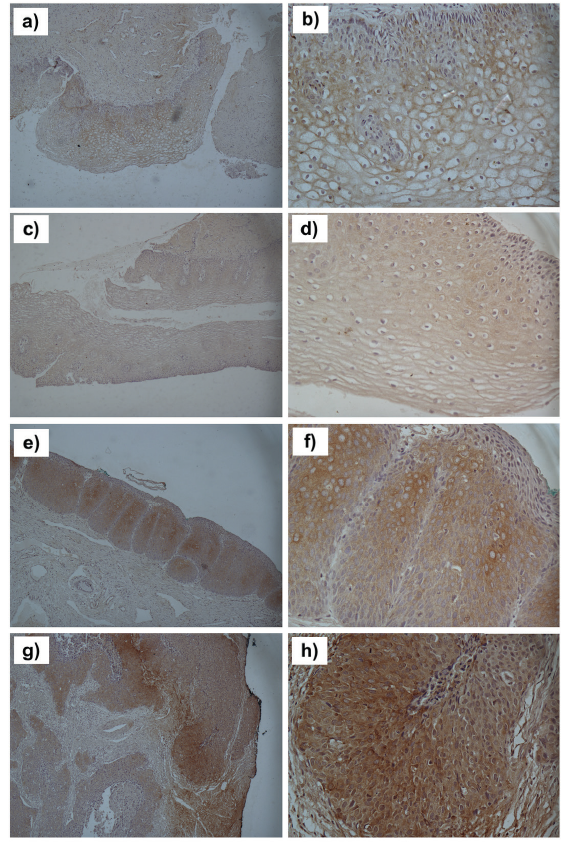
Figure 2. Representative immunohistochemistry images showing FASN expression in cervical tissue. FASN was detected in cervicitis (a, b), LSIL (c, d), HSIL (e, f) and carcinoma (g, h) samples. Images in panels a, c, e and g are at original magnifi cation and 200X magnifi cation; images in panels b, d, f and h are at original magnifi cation and 400X magnifi